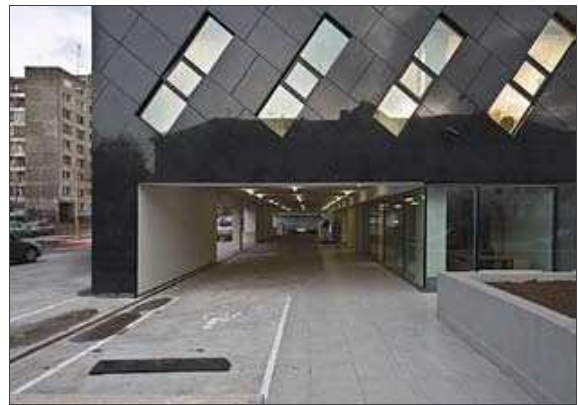
Fig. 24. Prosecutor's Office building main entrance, Vilnius. arch. k. Lupeikis,